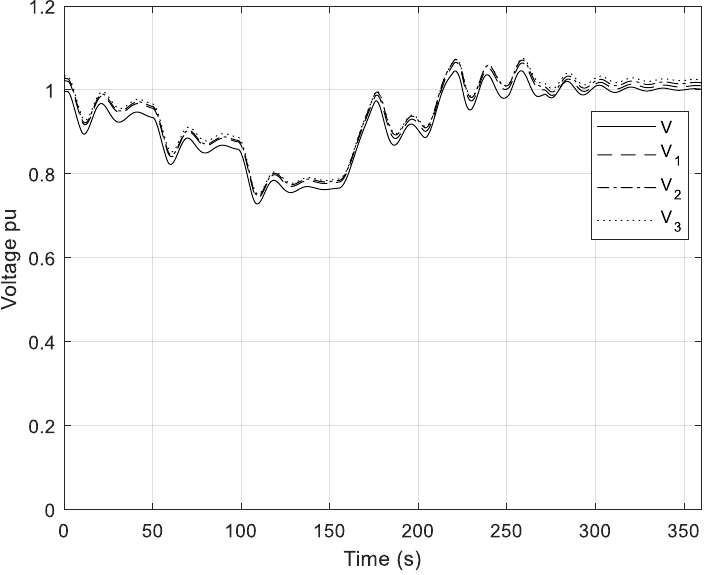
Figure 15. Regulated voltage V r and voltages V 1 – V 3 of PMSGs.